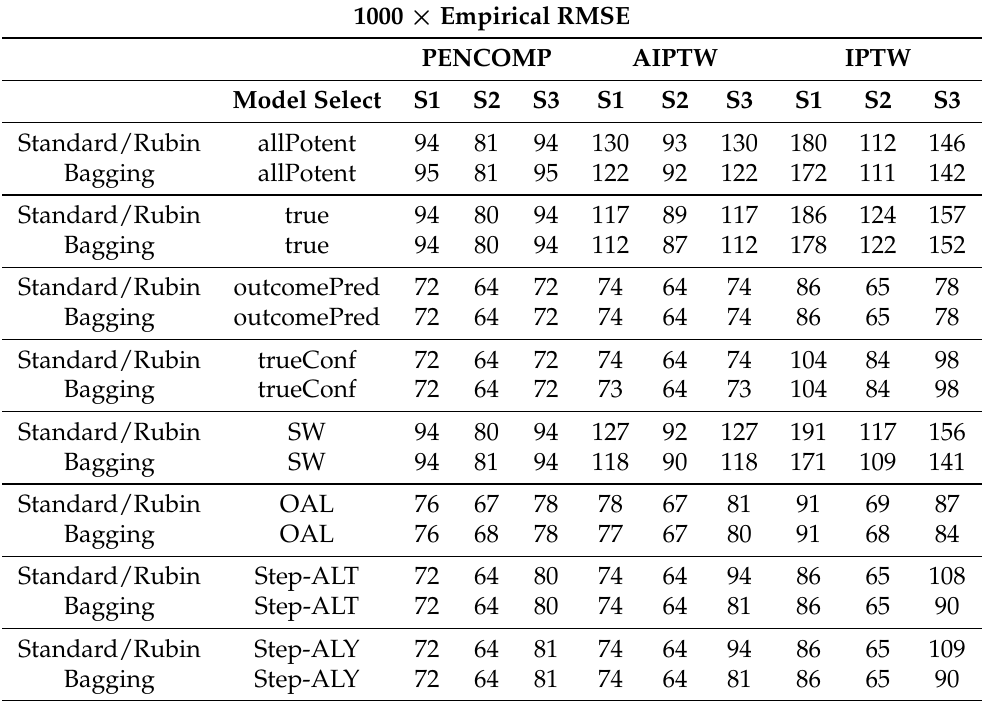
Table 3. 1000 × RMSE with sample size of 1000. The treatment effects η = 2. S1, S2, and S3 denote scenario 1, 2, and 3, respectively.